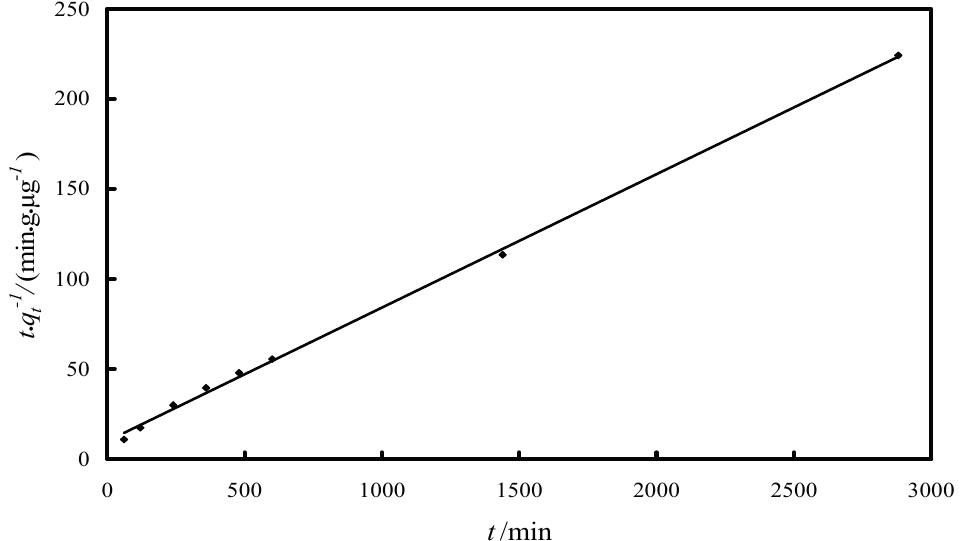
Figure 6. Linear model of the pseudo-second-order reaction kinetics of As(V) adsorption onto Fe-XAD8-DEHPA